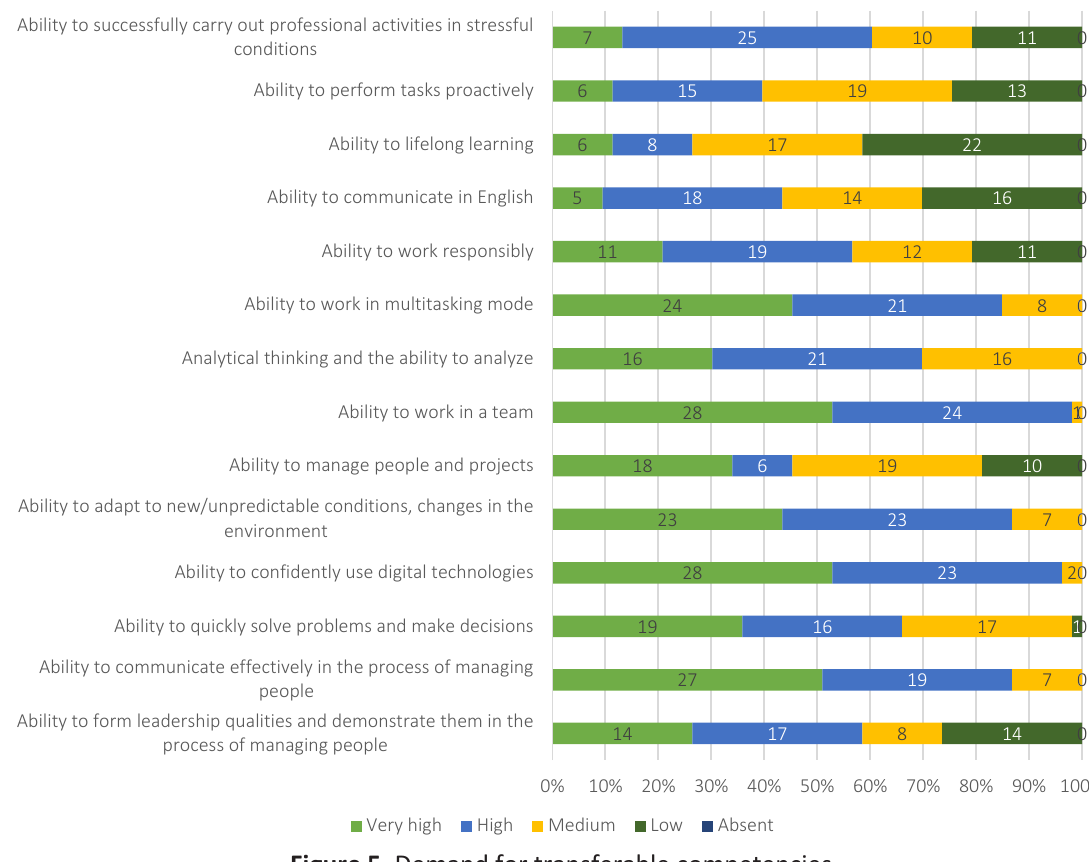
Figure 5. Demand for transferable